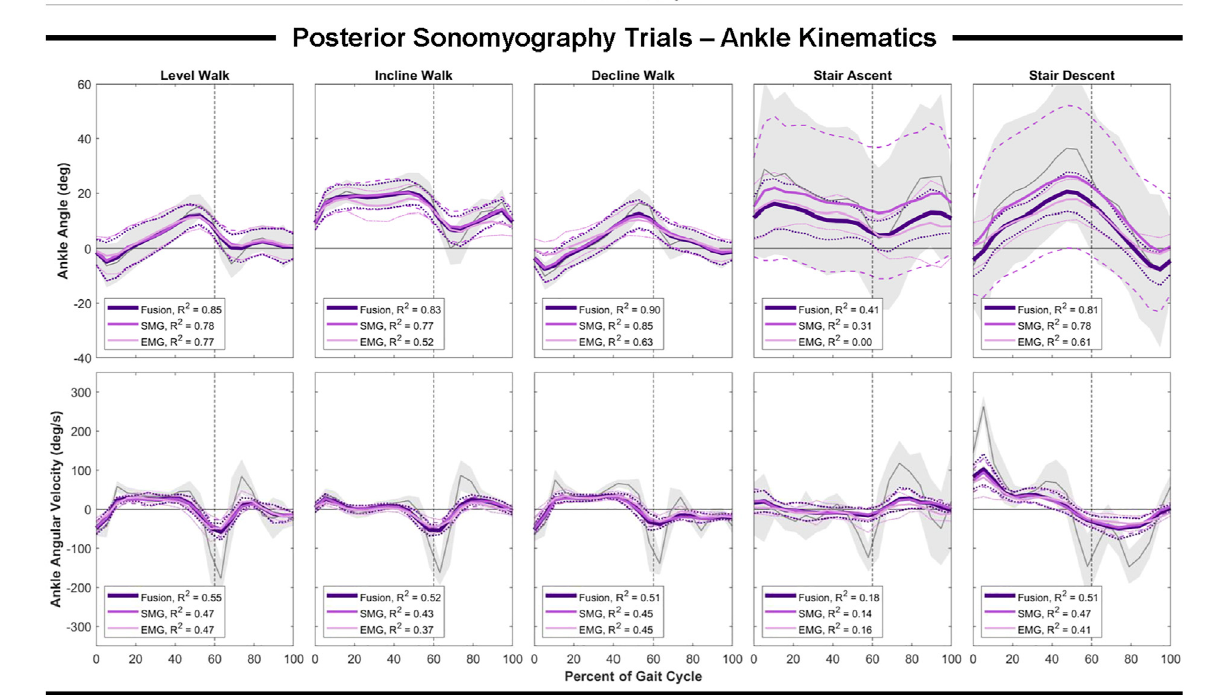
anterior thigh (rectus femoris, vastus intermedius, and vastus